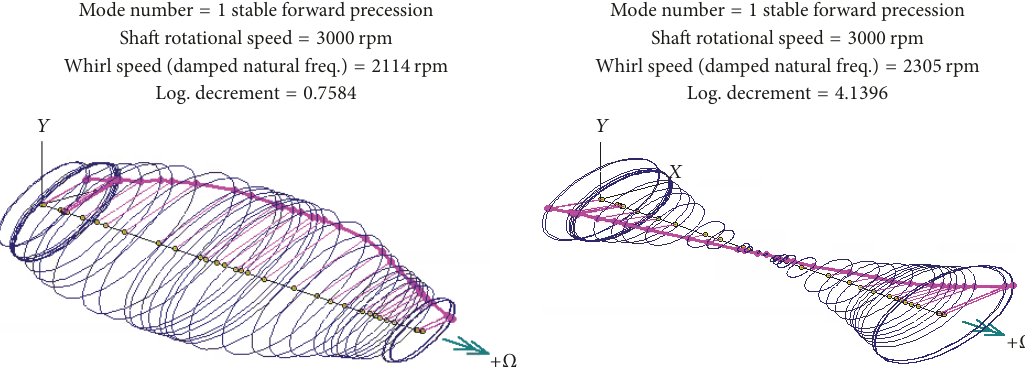
Figure 4: Modal analysis of the cylindrical bearing-rotor system.